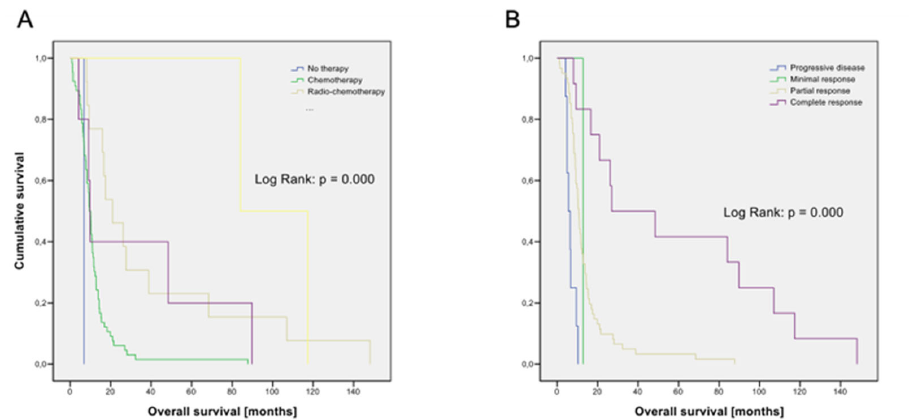
Figure 3. ( A ) Kaplan–Meier graph for overall survival according to first ‐ line therapy. N = 87. No therapy: n = 1; chemotherapy: n = 66; radio ‐ chemotherapy: n = 13; surgery and chemotherapy: n = 5; surgery and radio ‐ chemotherapy: n = 2. ( B ) Kaplan–Meier graph for overall survival according to Response to first ‐ line treatment. N = 82. Progressive disease: n = 8; minimal response: n = 1; partial response: n = 61; complete response: n = 12.